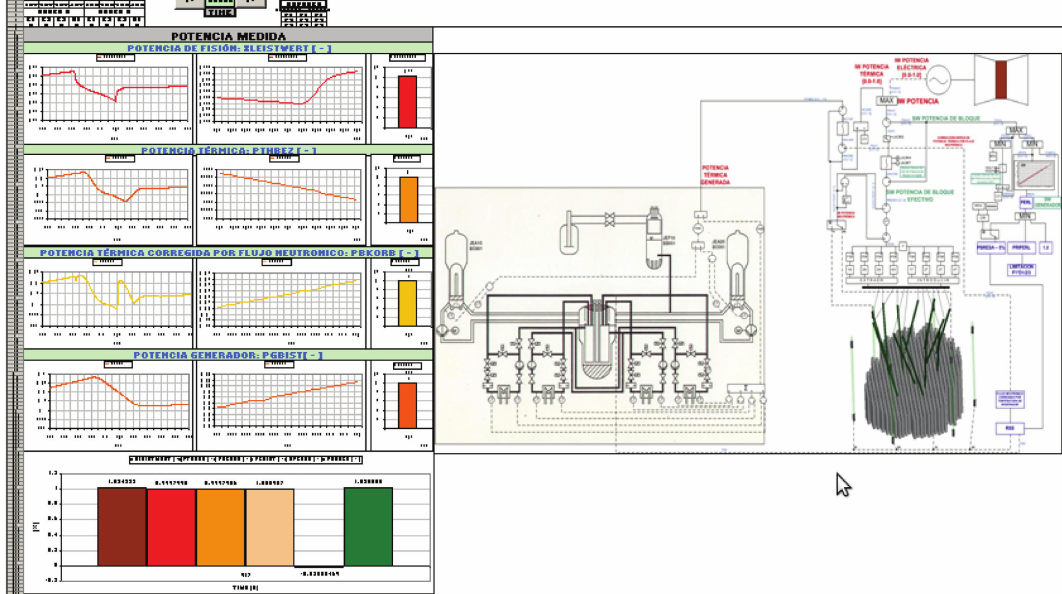
Figure 14: Postprocessing spreadsheet. Fission, thermal, corrected thermal, and generator power with schematics of the instrumentation and control